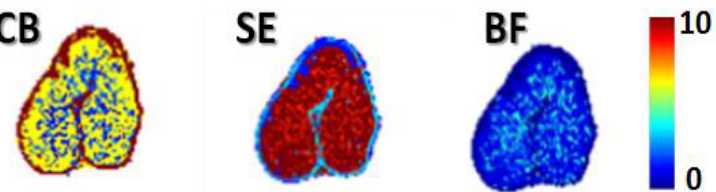
Figure 5. Probability images (represented in pseudo-colors) associated with a multispectral image of wheat kernel. High probability percentage indicates the region of the grain from which a given milled product was extracted. CB: coarse bran, SE: pure semolina and BF: break flours (Modified from Jaillais et al. [73]).